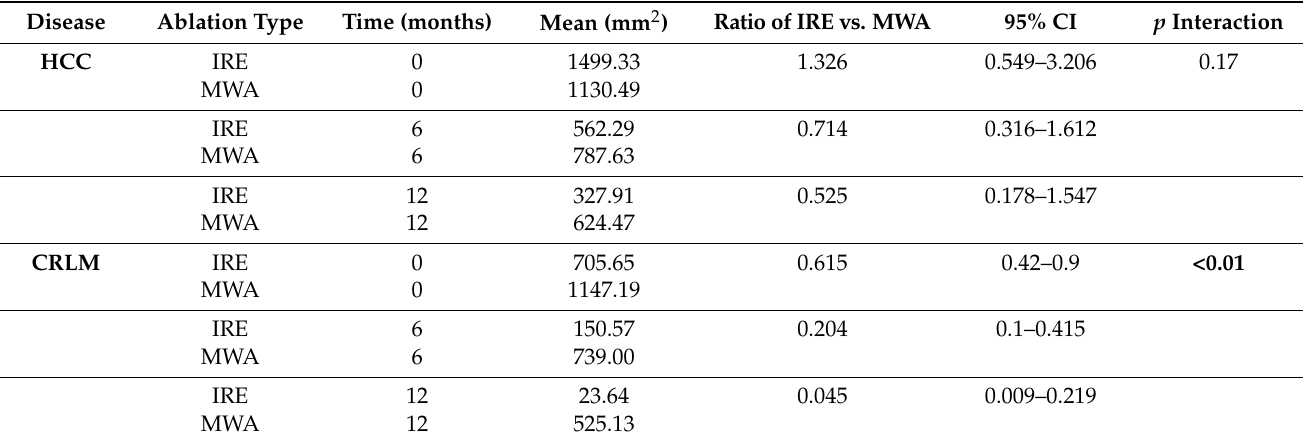
Within the subgroup of HCC, the difference in surface area recovery between IRE and MWA did not differ significantly over time (interaction p = 0.17). Within the subgroup of CRLM, the difference in surface area recovery between IRE and MWA differed significantly over time (interaction p < 0.01). Bold highlights the statistically significant p